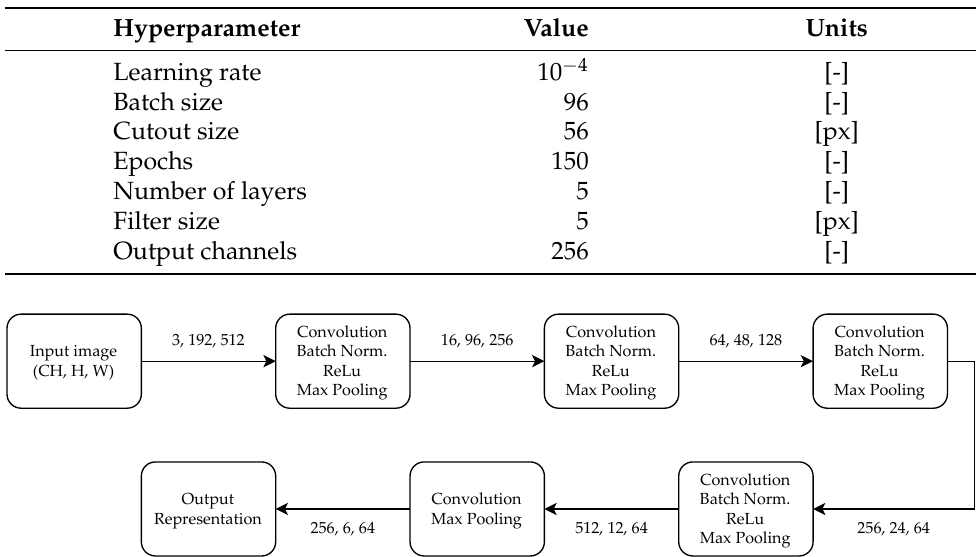
Table 1. Hyperparameters used for training of the best model.